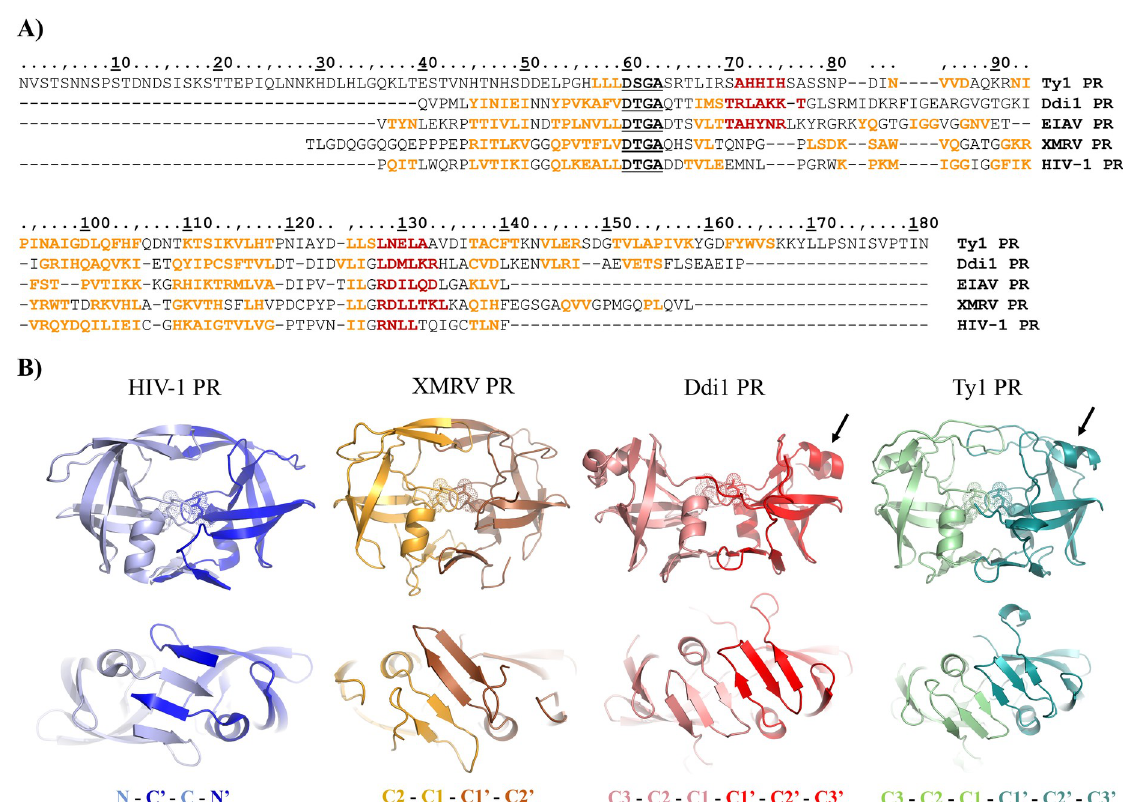
Fig 7. Sequences and structures of Ty1 PR and representative retroviral and retroviral-like proteases. (A) Sequences of Ty1, DNA damage-inducible protein 1 (Ddi1), equine infectious anemia virus (EIAV), xenotropic murine leukemia virus-related virus (XMRV), and human immunodeficiency virus type 1 (HIV-1) proteases were aligned. Arrangement of secondary structural elements is shown based on prediction for Ty1 PR, and based on crystal structures of Ddi1, EIAV, XMRV, and HIV-1 PRs, using DSSP (dictionary of protein secondary structure) images available in Protein Data Bank. Sequence numbering is shown for Ty1 PR. β -sheets and α -helices are indicated by orange and red, respectively. D-S/T-G-A catalytic motif residues are bold and underlined. (B) Cartoon representations are shown based on crystal structures of HIV-1, XMRV, and Ddi1 PRs, and based on homology model structure of Ty1 PR (41–164 residues). Upper panel shows the front views of the proteases, whereas bottom panel shows the enlarged views of dimer interfaces, together with the organizations of β -sheets. Additional helical inserts in the proximities of flaps (shown by arrows) are present only in the case of Ddi1 and Ty1 PRs. Catalytic aspartates are shown sticks and dots, while the monomers are differentiated by lighter and darker shades. N- and C-terminal extensions are not shown for Ty1 PR, structures of the full-length protease are shown in S3